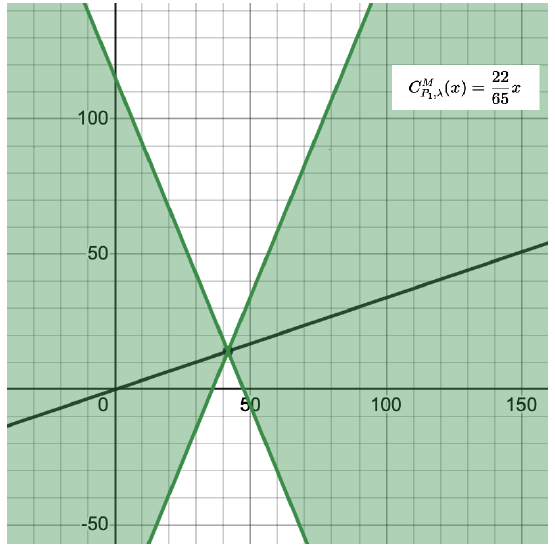
Figure 1. Graph of Lipschitz-continuous of generalized Cayley operator.